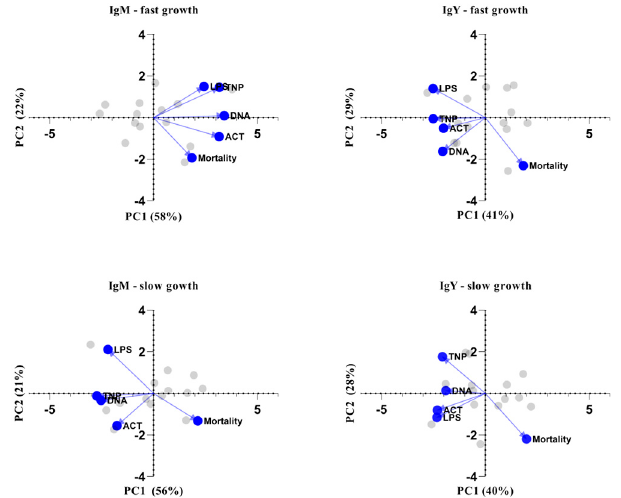
Figure 5. Biplots of principal component analysis. Biplot of the two principal components (PC) showing the individual scores (grey) and the loadings (blue) of the five characteristics: levels of IgM or IgY NAbs against actin, DNA, TNP and LPS, as well as mortality. PCA analysis was performed based eigenvalues meeting the “Kaiser rule”. The variability for every PC is given in the axis title.